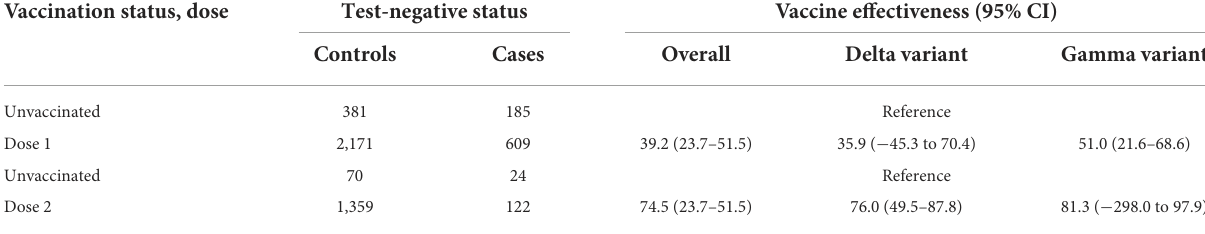
TABLE 3 Vaccine effectiveness against any COVID-19 illness, overall and by strain, multivariate analysis only. Vaccination status,